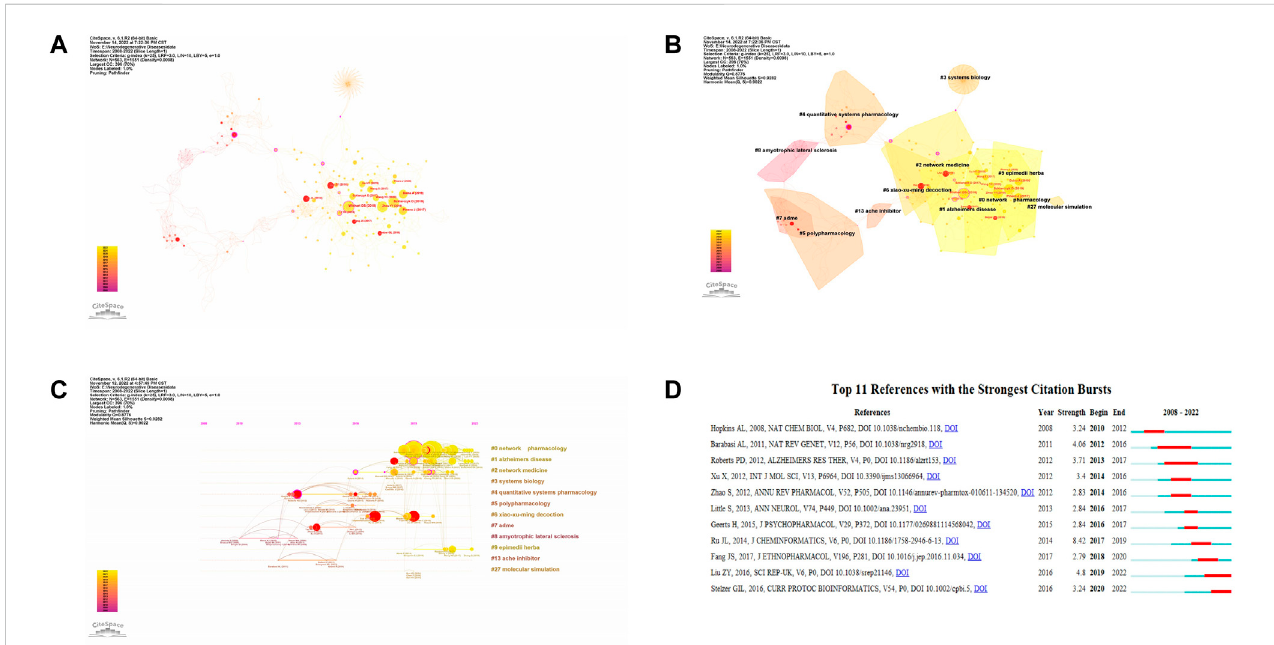
FIGURE 7 Analysis of most commonly cited references. (A) Visualization of co-cited references. (B) Cluster analysis of co-cited references. (C) Timeline graph of cluster analysis. (D) Top 11 references with the most strongest bursts.